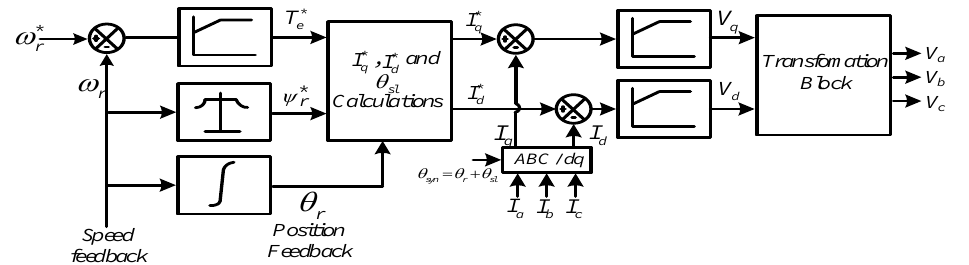
Figure 2. Indirect Field-Oriented Control Scheme.